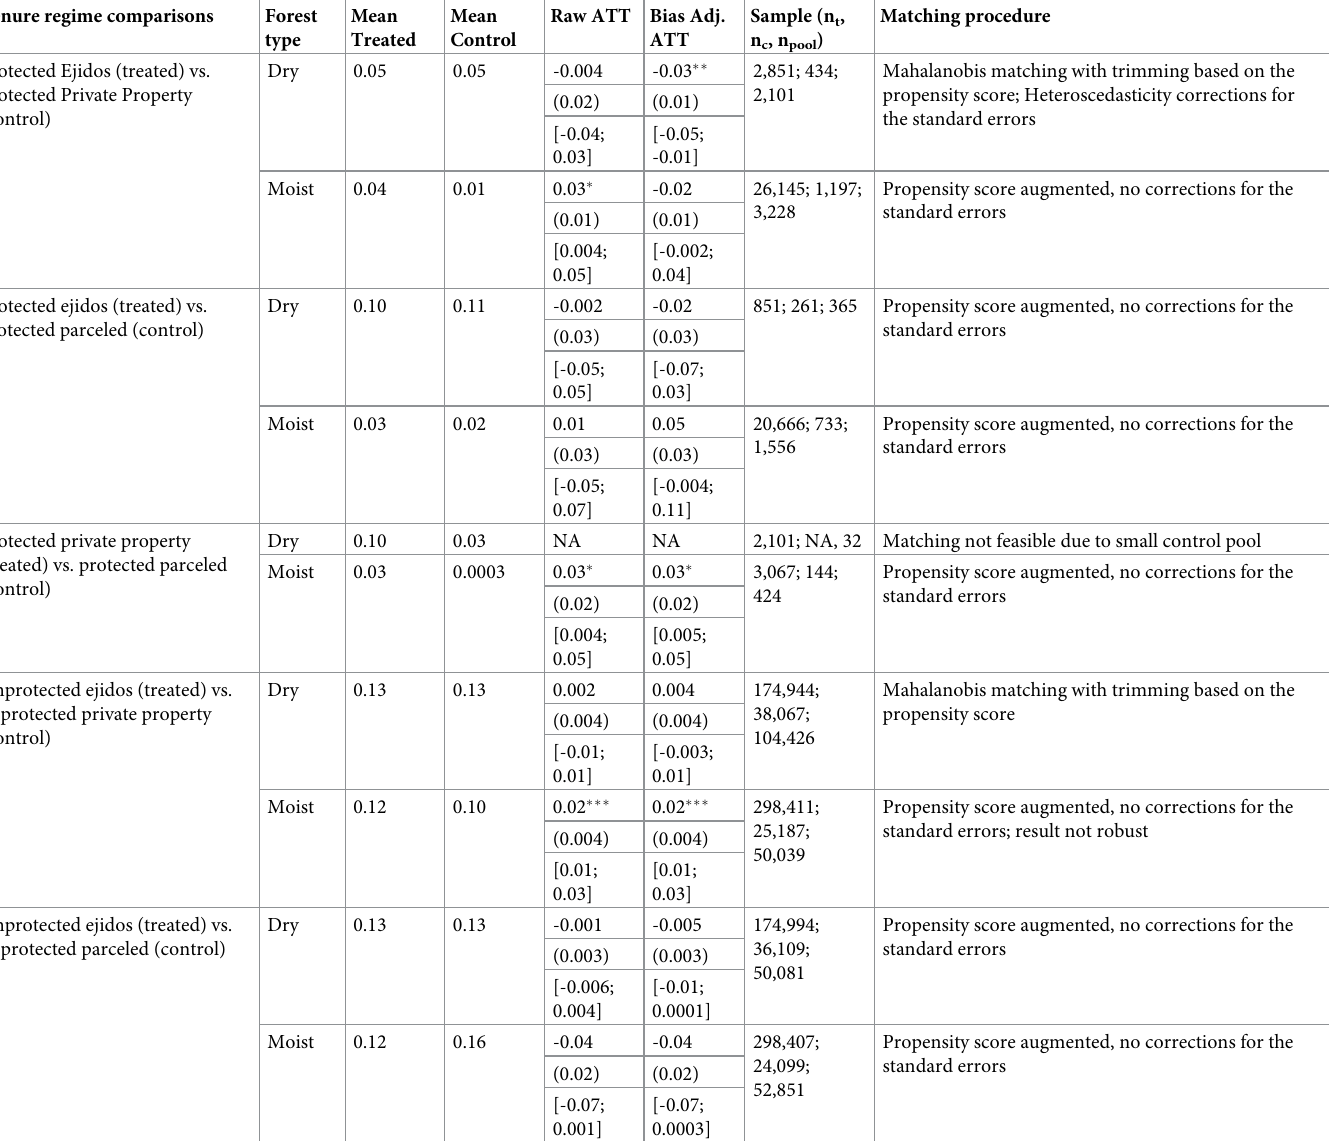
Table 6. Average impact of tenure regimes on deforestation, proxied by the average treatment effect on the treated (ATT). The standard errors are given in parenthe- ses and confidence intervals corresponding to each significance level—in square brackets. n t , n mc , n cp indicate treated (on support), matched control, and control pool observations, respectively. A negative sign of the ATT indicates that deforestation in ejidos decreased the probability of forest loss relative to private